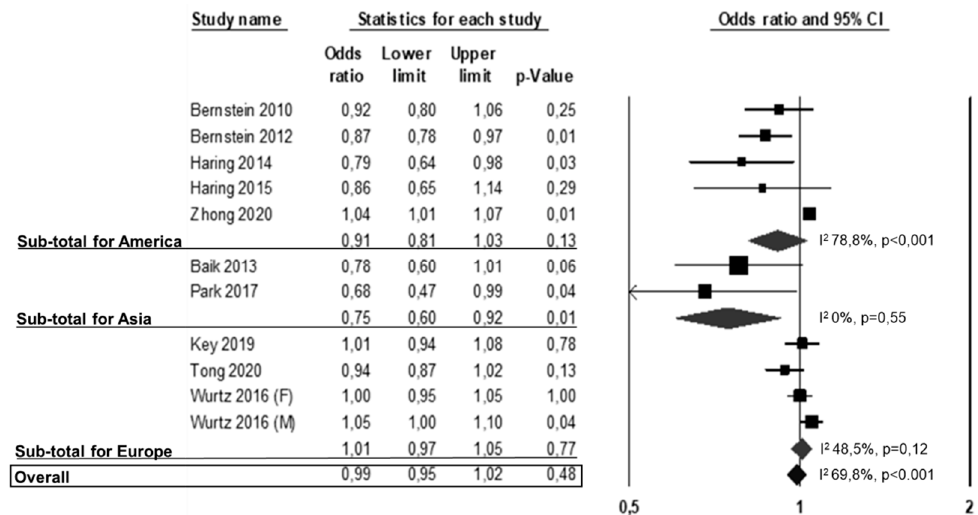
Figure 4. Association between white meat consumption (highest vs. lowest) and non-fatal CV events. F: females; M: males.